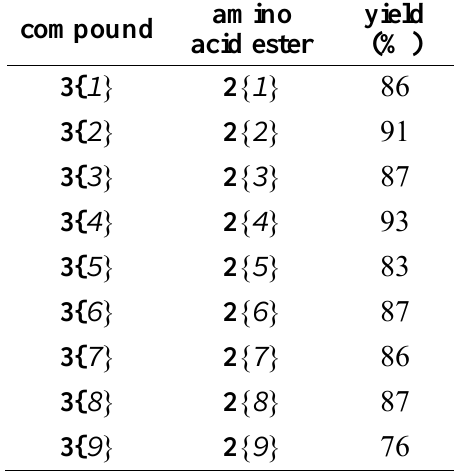
Table 3. Pyrazines Substituted with Amino Acid Esters, 3 { 1 - 9